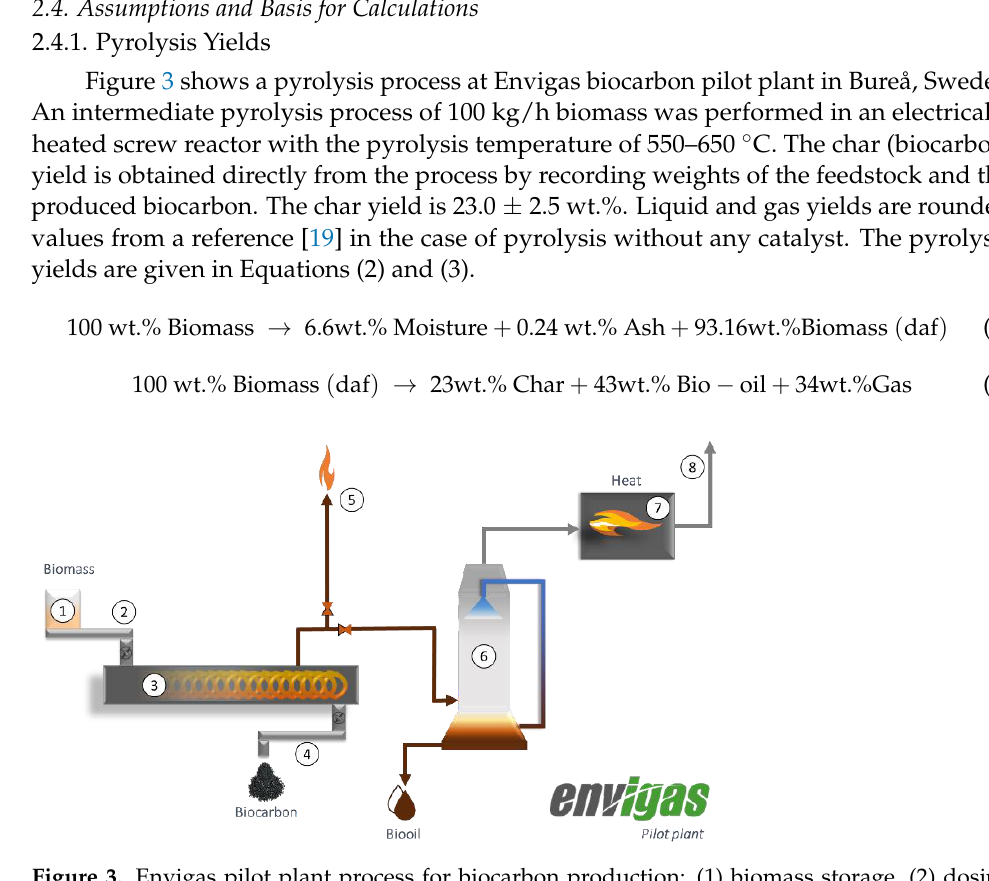
Figure 3. Envigas pilot plant process for biocarbon production: (1) biomass storage, (2) dosing screw, (3) electrically heated pyrolysis screw reactor, (4) char cooling screw, (5) emergency flare, (6) condenser, (7) off-gas burner, (8) exhaust pipe.